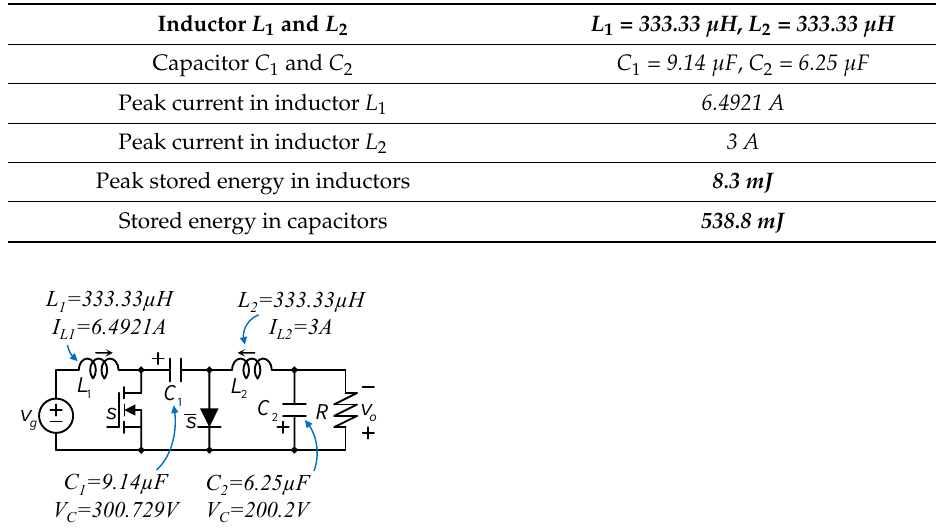
Figure 14. Result of the design with the Cuk converter topology.